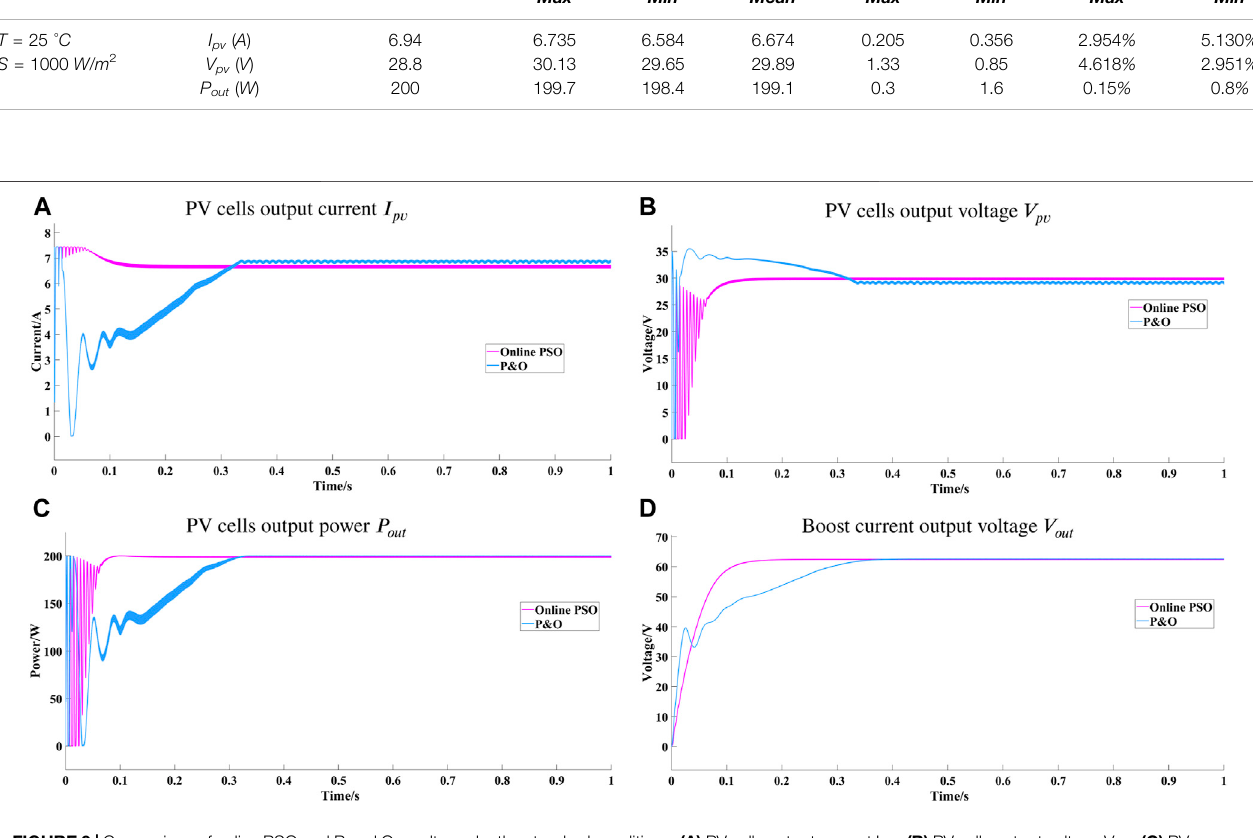
Frontiers in Energy Research |